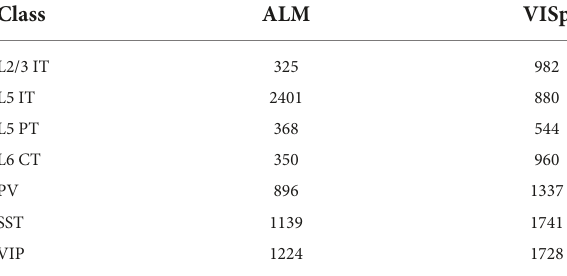
TABLE 1 Number of cells analyzed for each neuronal class and cortical